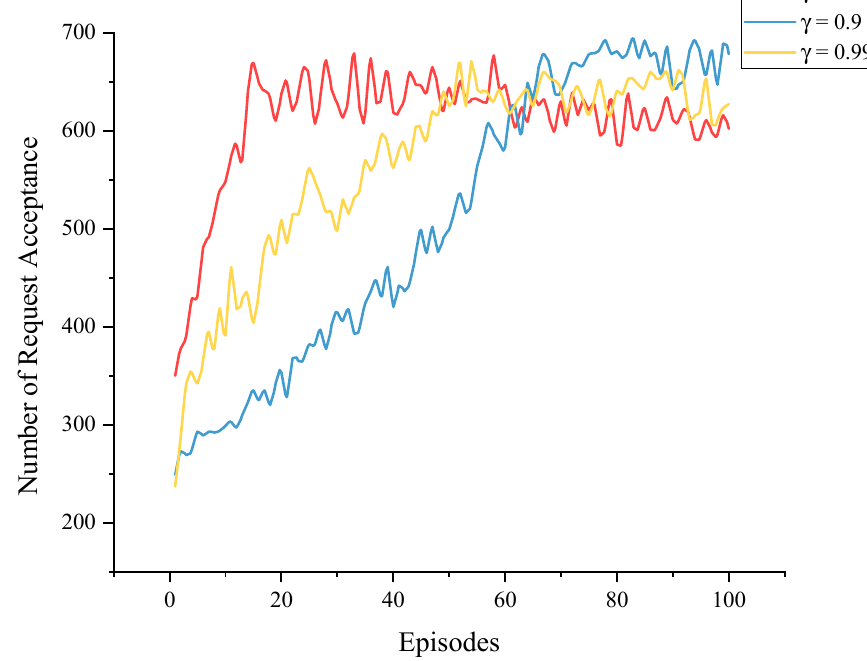
Figure 10. Training processes with different γ values.